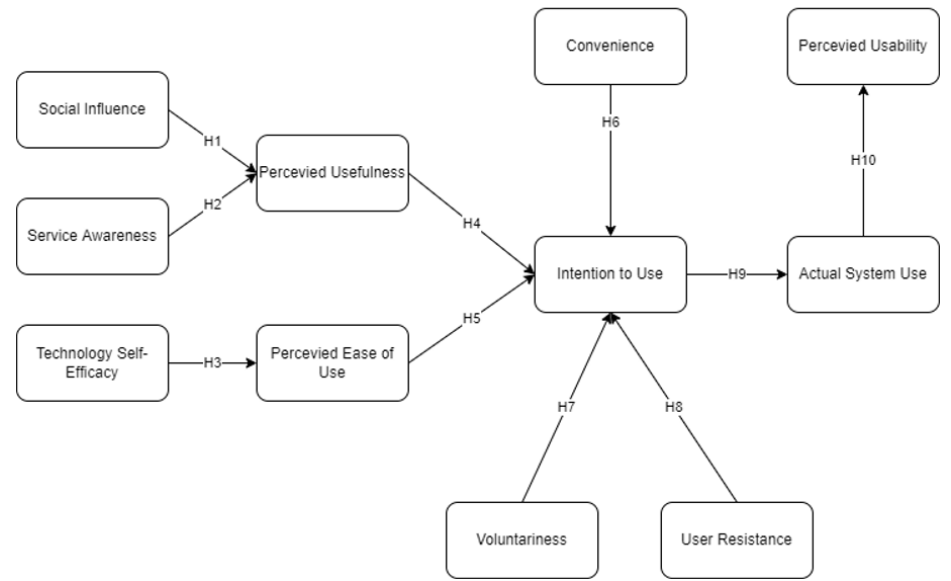
Figure 2. Conceptual research framework.